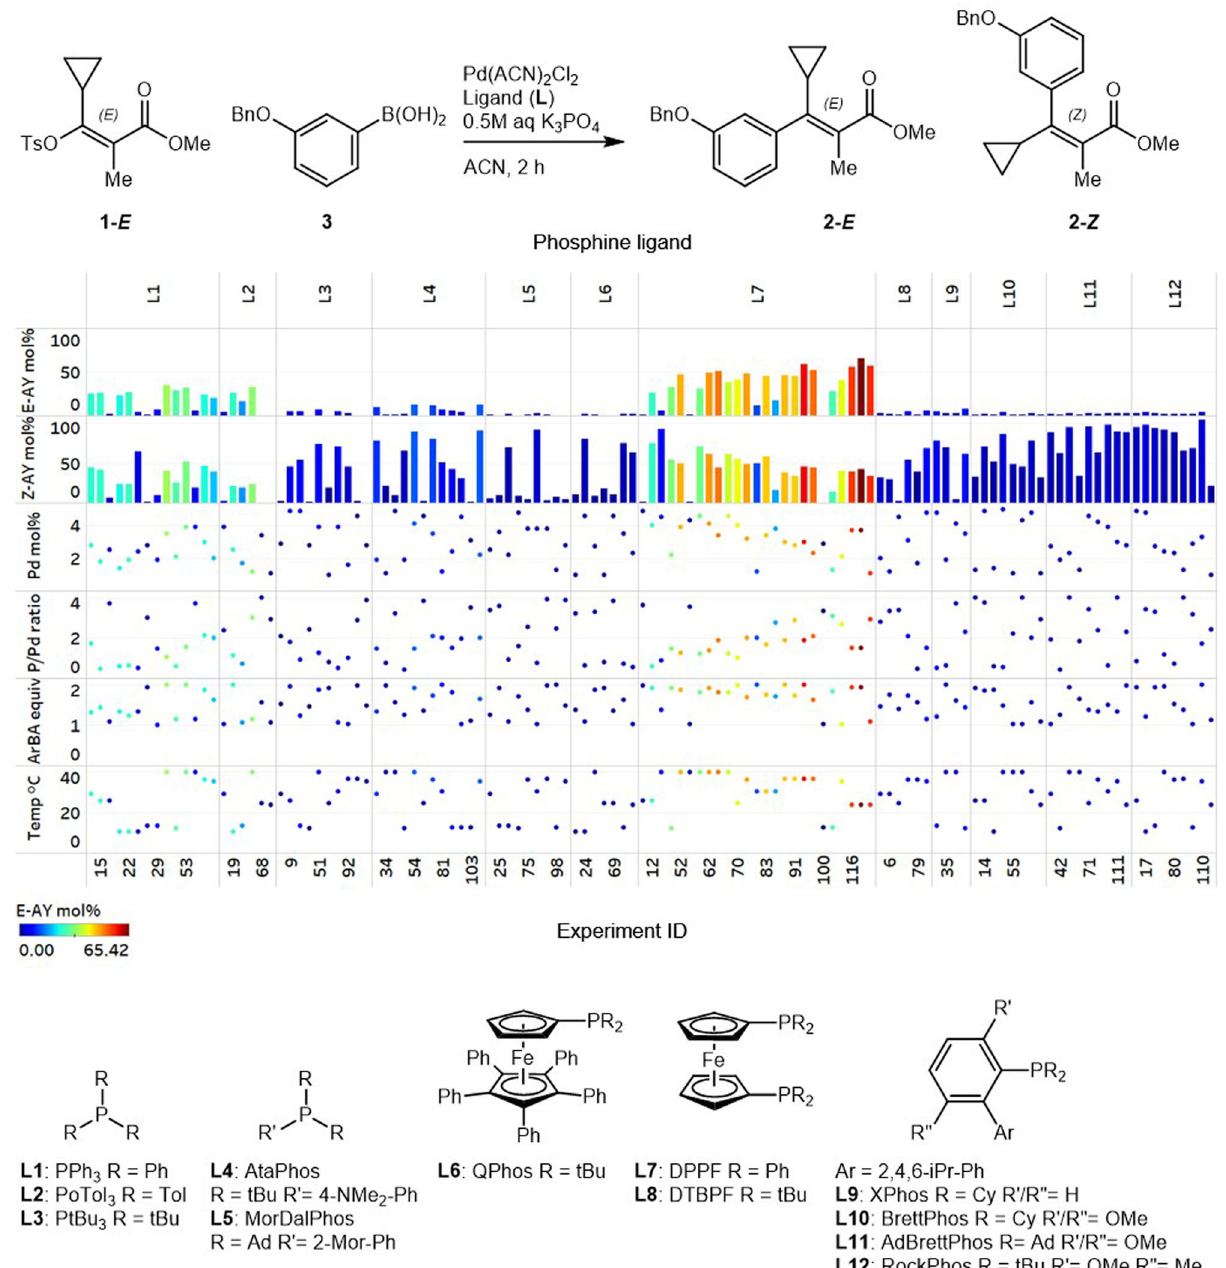
Fig. 4 Parameters and results of optimization with ligands selected through chemical intuition in campaign 1. Conditions: 10 µ mol 1- E , 1 µ mol